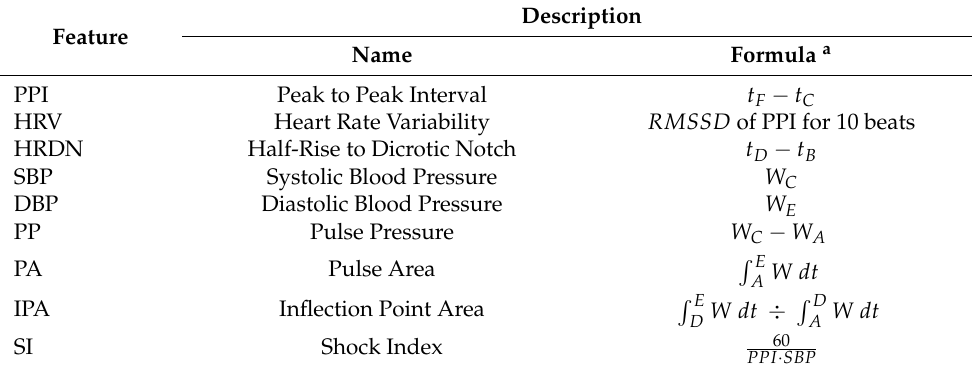
Figure 2. Landmark points on Finapres ABP pulse corresponding to (A) start of pulse, (B) systolic half-rise, (C) systolic peak, (D) dicrotic notch, (E) end of pulse, and (F) systolic peak of successive pulse. Table 2. ABP Feature Descriptions.